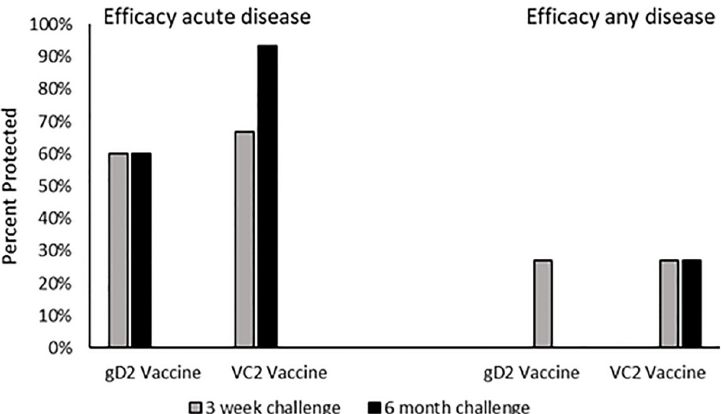
Fig 4. Efficacy of vaccination when evaluated against acute disease defined as development of genital lesions within two weeks of vaginal virus challenge or against any genital lesions that were detected during the observation period, seven weeks post vaginal virus challenge. The seven week observation includes recurrent lesions that develop after recovery from the acute disease.